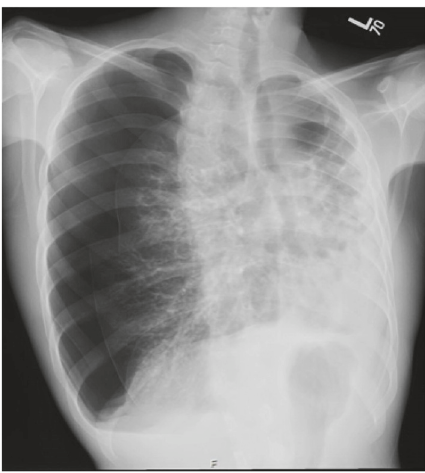
Figure 1: Chest X-ray on admission showing a right-sided pneu- mothorax prior to insertion of the chest tube.